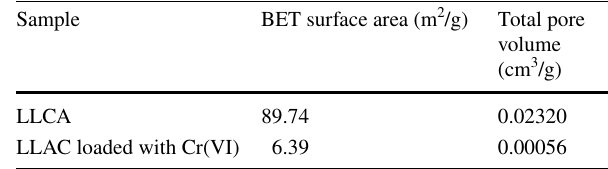
Table 2 Textural properties of prepared LLAC adsorbent before